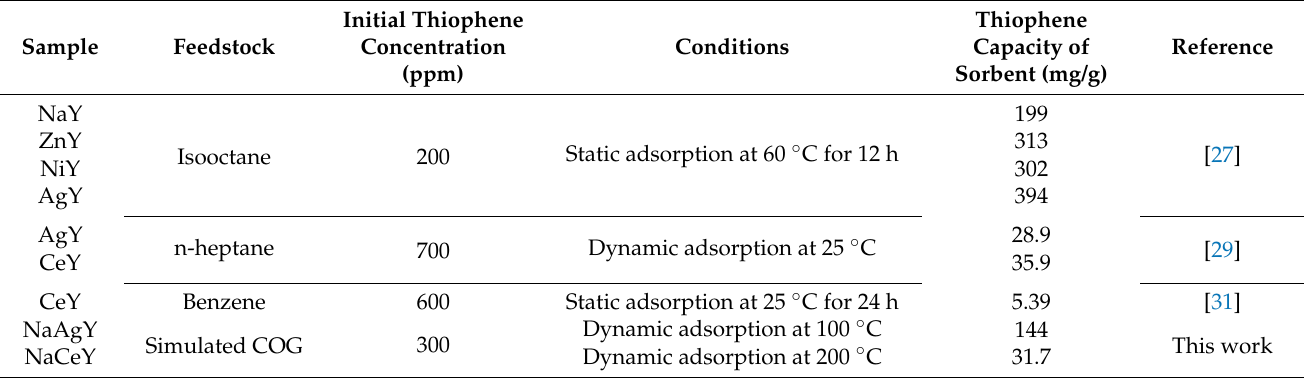
Table 2. A comparison of thiophene adsorption capacity of different Y zeolites at various condi- tions.